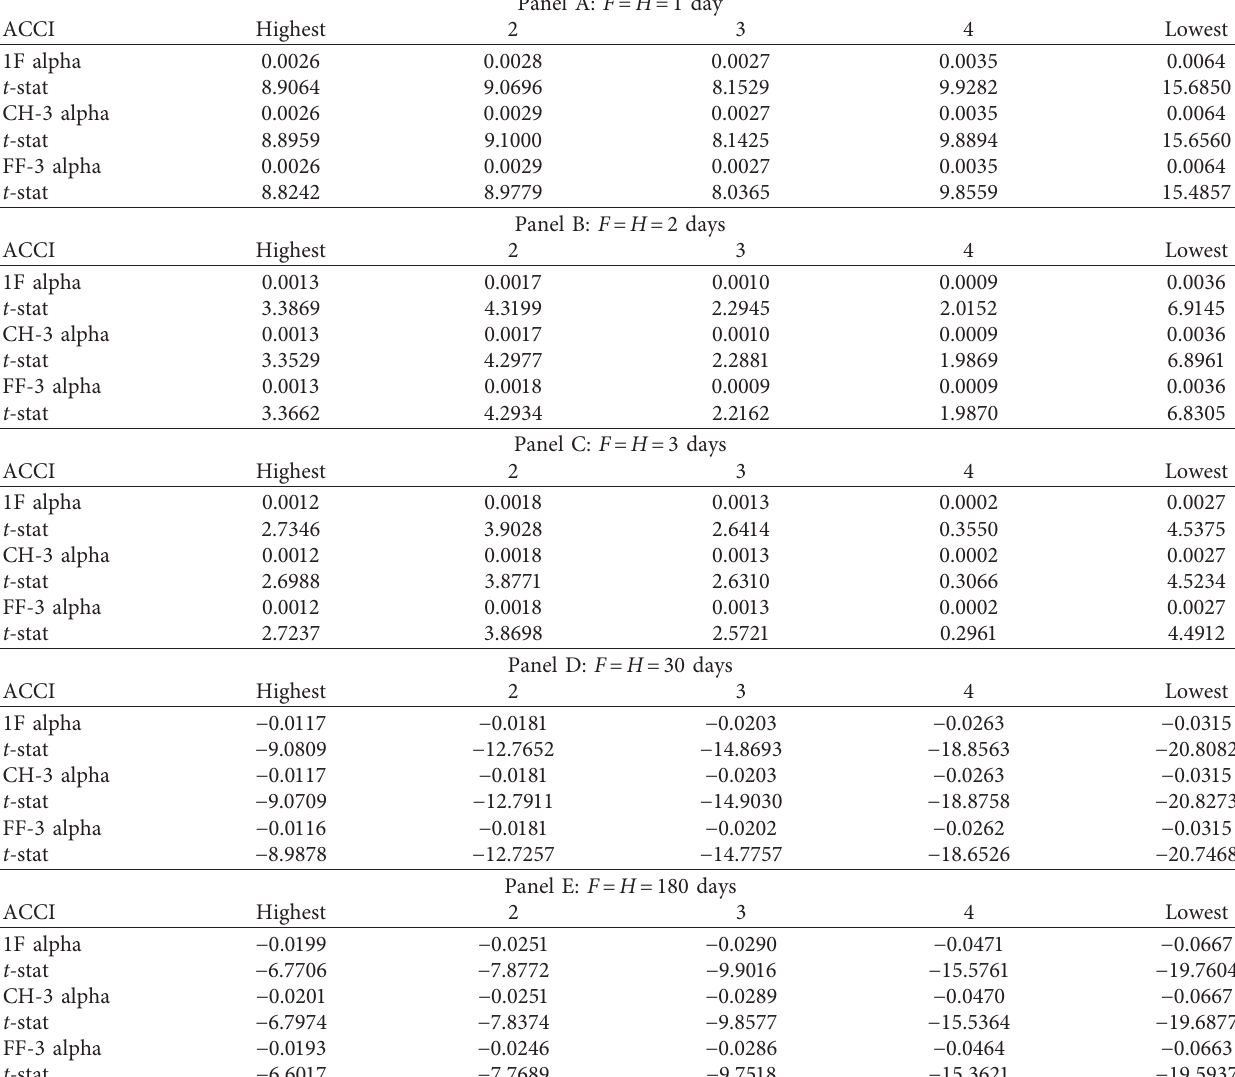
Table 5: The effect of the accumulative relative order imbalance after risk adjustments of the A-share